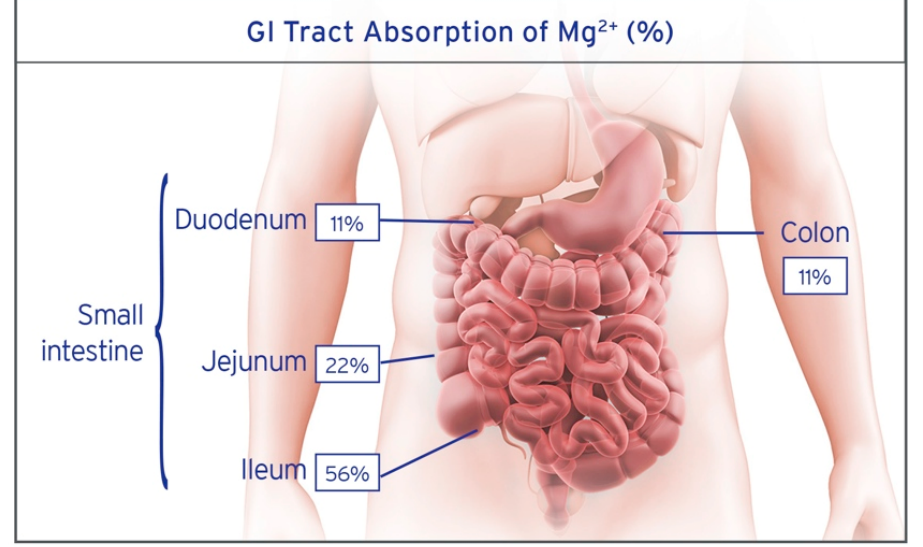
Figure 3. Percentage of magnesium absorption in the GI tract. The majority of magnesium is absorbed in the distal portion of the small intestine. The ileum absorbs 56%, the jejunum 22%, the duodenum 11%, and colon 11% [3,58].